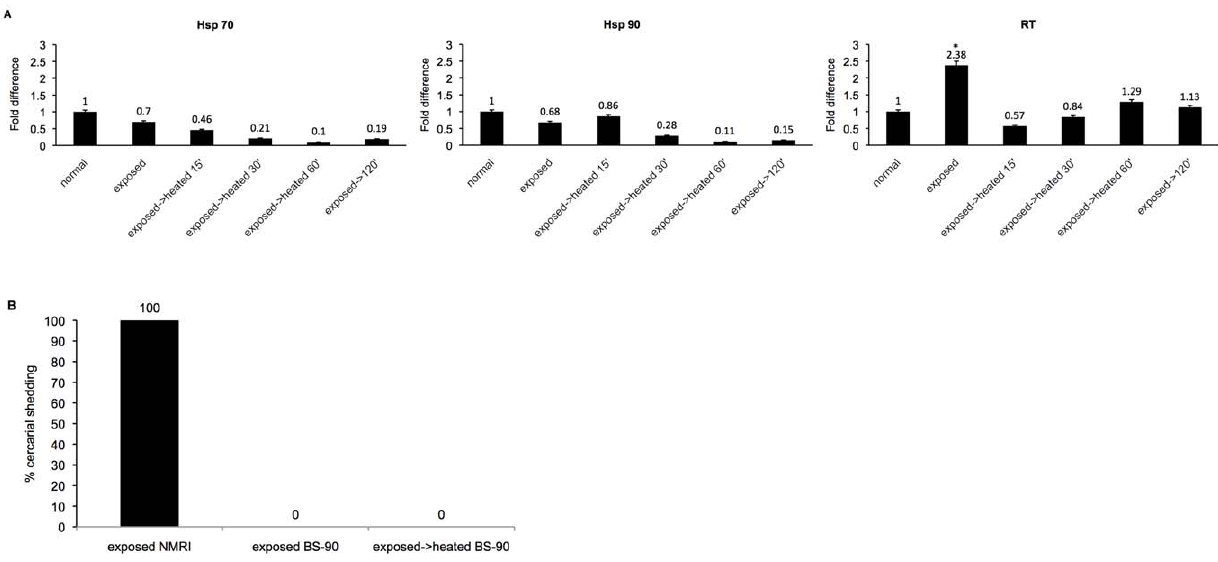
Figure 4. Expression of stress –related transcripts in parasite exposed juvenile resistant BS-90 snails followed by heat-pulse treatment for various time points (0–120 min). ( A ) Real time qPCR analysis of the fold difference in expression of transcripts corresponding to Hsp 70, Hsp 90, and RT in either normal BS-90 resistant snails, exposed snails, or those that were first exposed to S. mansoni before being subjected to heat-pulse at 32 u C for various time points (15–120 mins). These data were pooled from 10 biological replicates of 5 independent experiments. Note the lack of up-regulation of all transcripts in snails that were exposed and then subsequently kept at 32 u C. The asterisk* denotes significant upregulation of one of the transcripts, RT, by Student t -test with P-value , 0.05 (N=50). ( B ) Results showing 100% shedding of cercariae from susceptible NMRI snails after 7 weeks PE to S. mansoni miracidia compared to similarly exposed normal BS-90 snails, or those that were exposed before being subjected to heat pulse treatment at 32 u C. It is clear that no cercariae were shed from BS-90 snails in either of these two groups. These